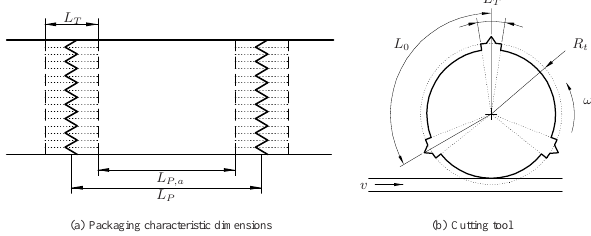
Figure 2. Characteristic dimensions.